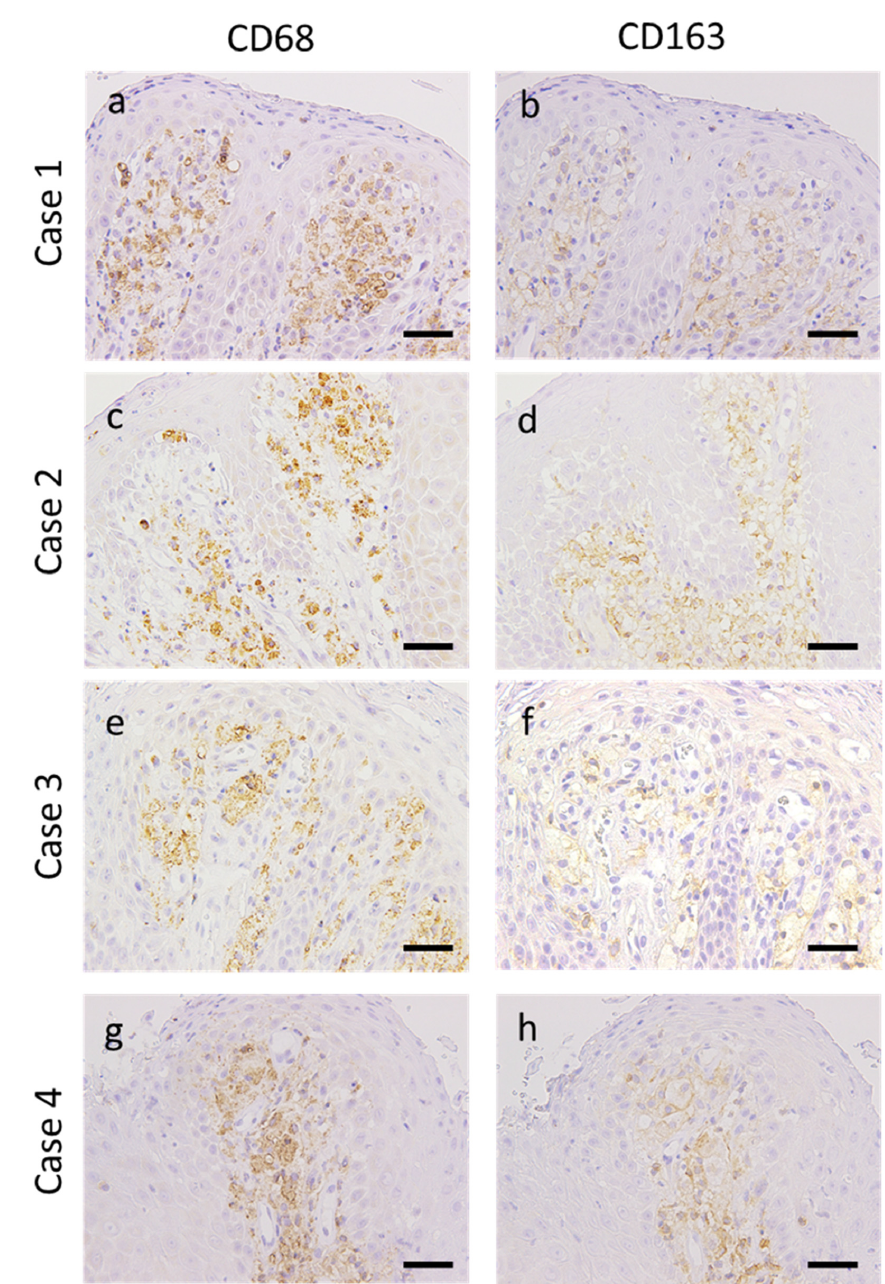
Figure 2. Immunoreaction of macrophage markers in patients with oral verruciform xanthoma. Representative images of CD68 and CD163 expression in oral verruciform xanthoma. ( a , c , e , g ) CD68 was positive in the foamy cells of all patients with a cytoplasmic pattern. ( b , d , f , h ) CD163 was positive in the foamy cells of all patients with a membranous pattern (scale bar, 20 μ m; original magnification, 400×).